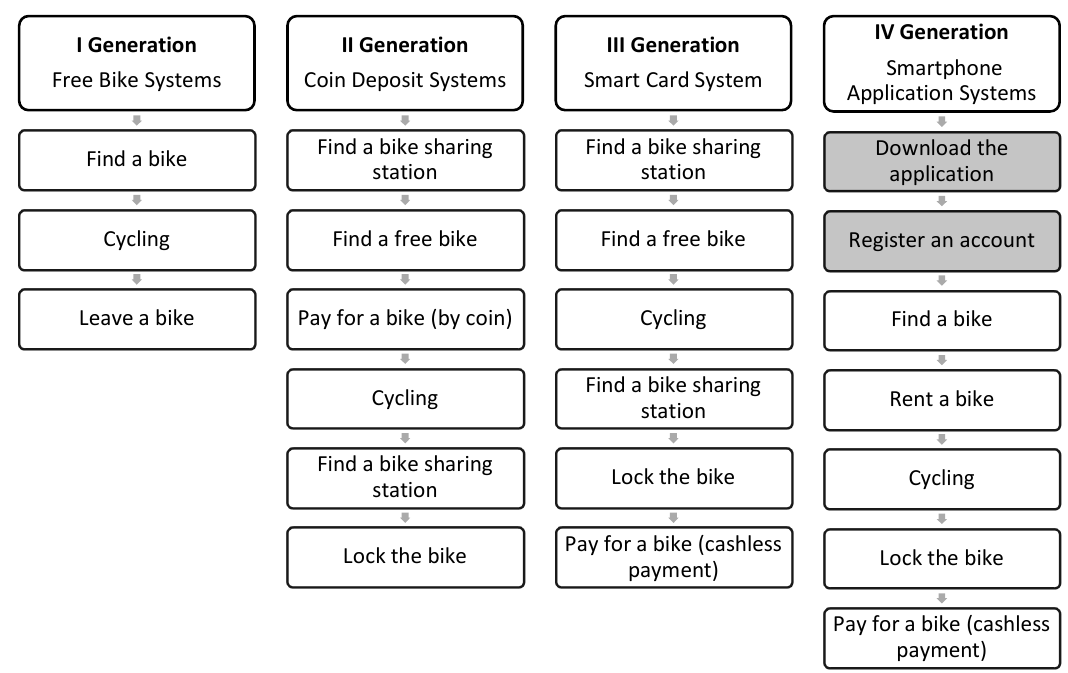
Figure 1. Operational schemes of municipal bikes of different generations from the user perspective. Source: own elaboration. Explanatory note: gray elements refer to stages the user is required to perform only once.